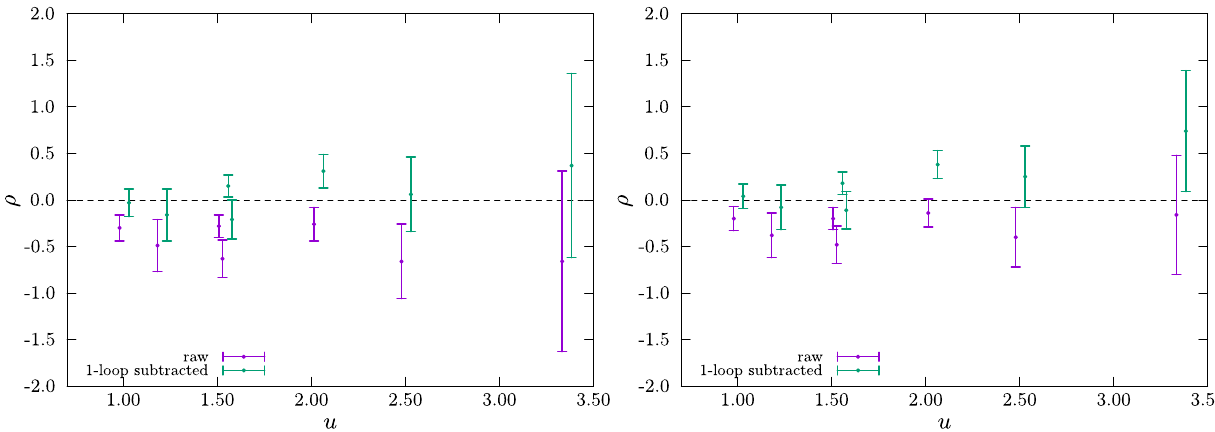
N f = 2 in the scheme α = 0 (left) and α = 1 / 2 (right), illustrating the effect of T for